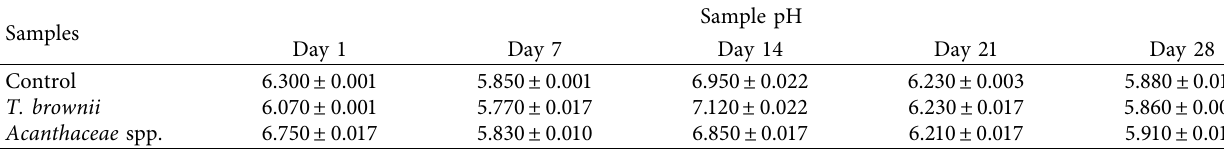
Figure 2: UV-VIS analysis of T. brownii and Acanthaceae spp. extracts. The spectra show more peaks toward the blue end of the Table 1: changes in pH value of bioslurry.